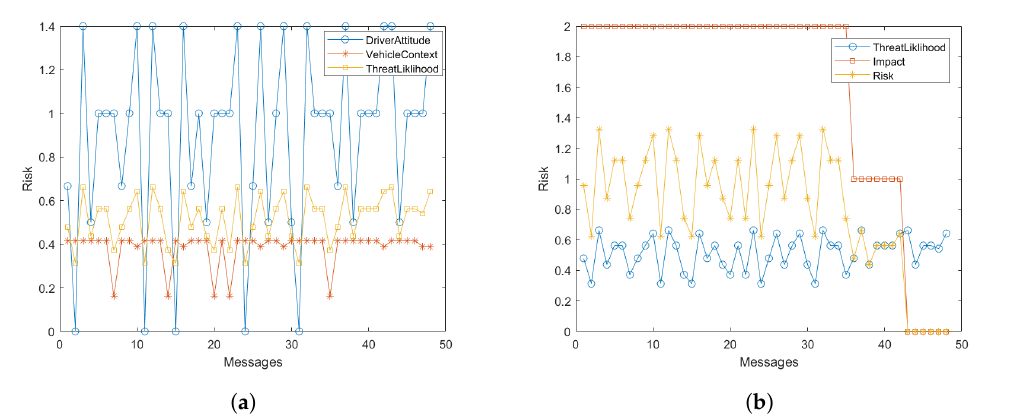
Figure 5. Simulation-based Risk analysis. ( a ) Threat likelihood for each message; ( b ) Risk values for each message.